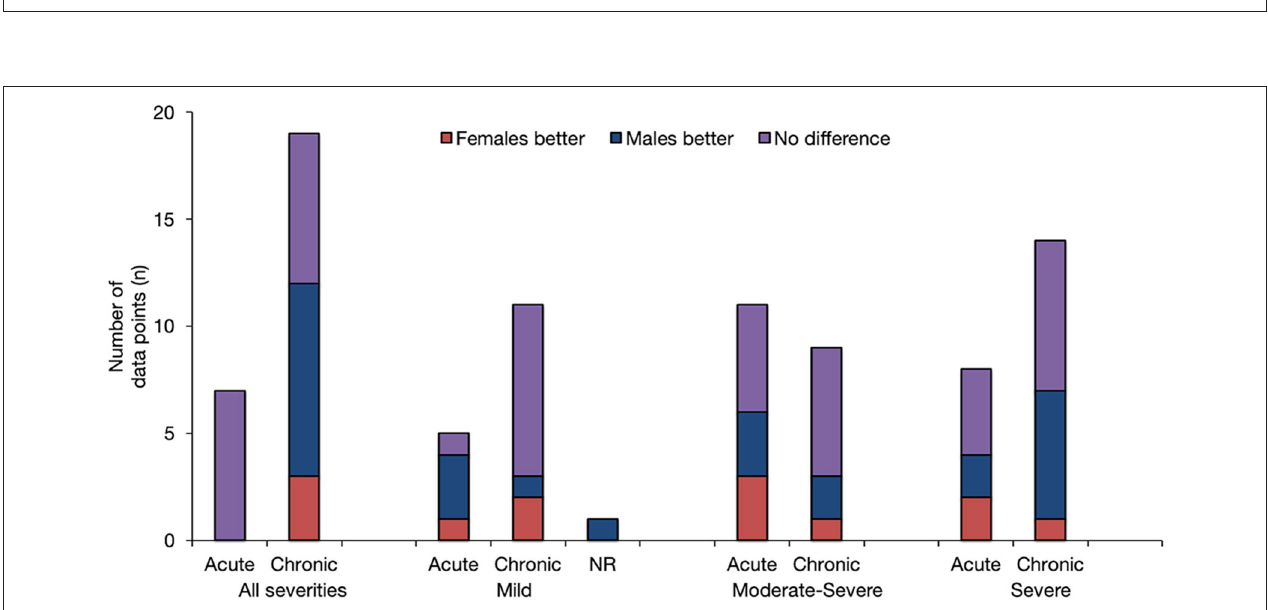
FIGURE 2 | Findings overview overall, by outcome. The results are stratified according to assessed outcome. The height of the bar is only an indicator of assessment frequency at a certain point in time.